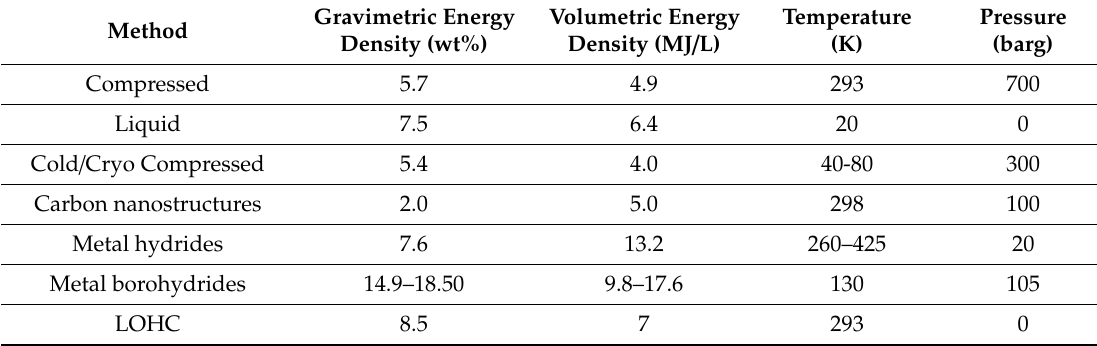
Table 1. Storage methods